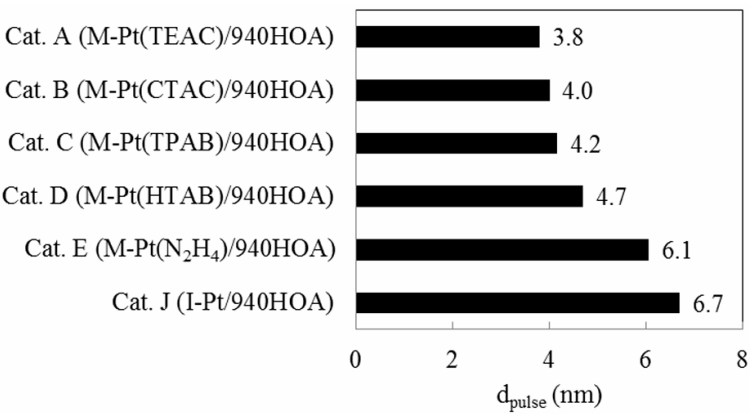
Figure 3. XRD patterns of Cat. A–E and J.